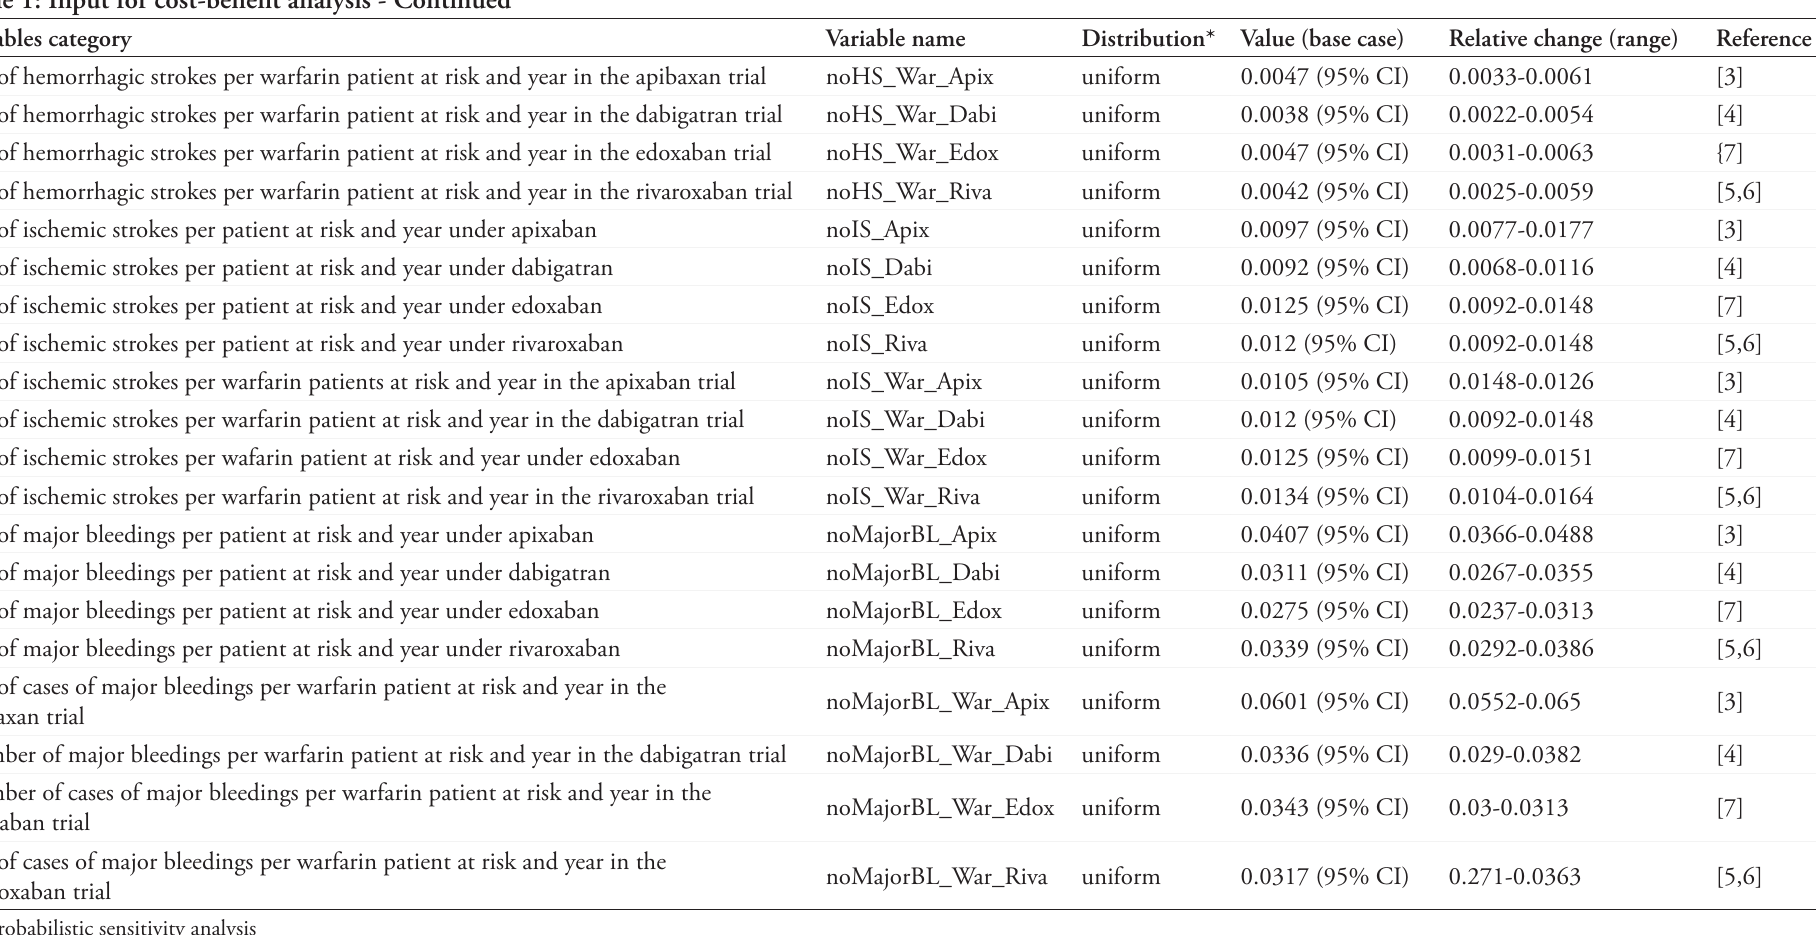
Table 1: Input for cost-benefit analysis -